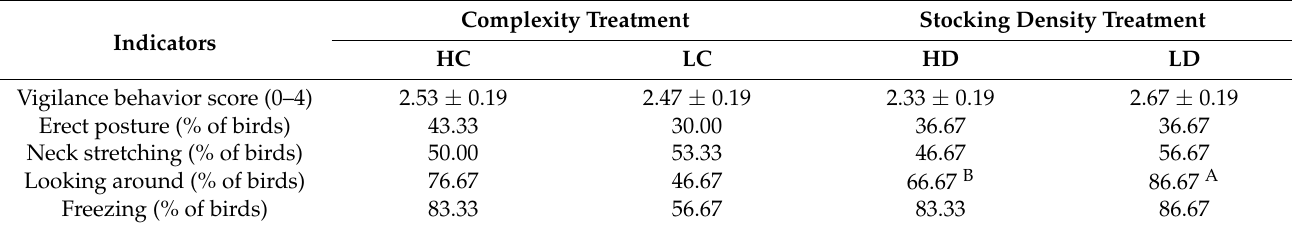
Table 5. Least squares mean estimates ( ± SEM) for vigilance behavior scores and % of total observations that each type of vigilance behavior was observed for broiler chickens kept in high-complexity (HC), low-complexity (LC), high-density (HD), and low-density (LD) treatments ( n = 60) in Experiment 1 at 4 weeks of age (days 30, 32, and 33). Birds were scored either 0 (not observed) or 1 (observed) for each of four vigilance behavior characteristics (erect posture, neck stretching, looking around, and freezing), giving a vigilance score between 0 (no vigilance behavior observed) and 4 (all vigilance behaviors observed).